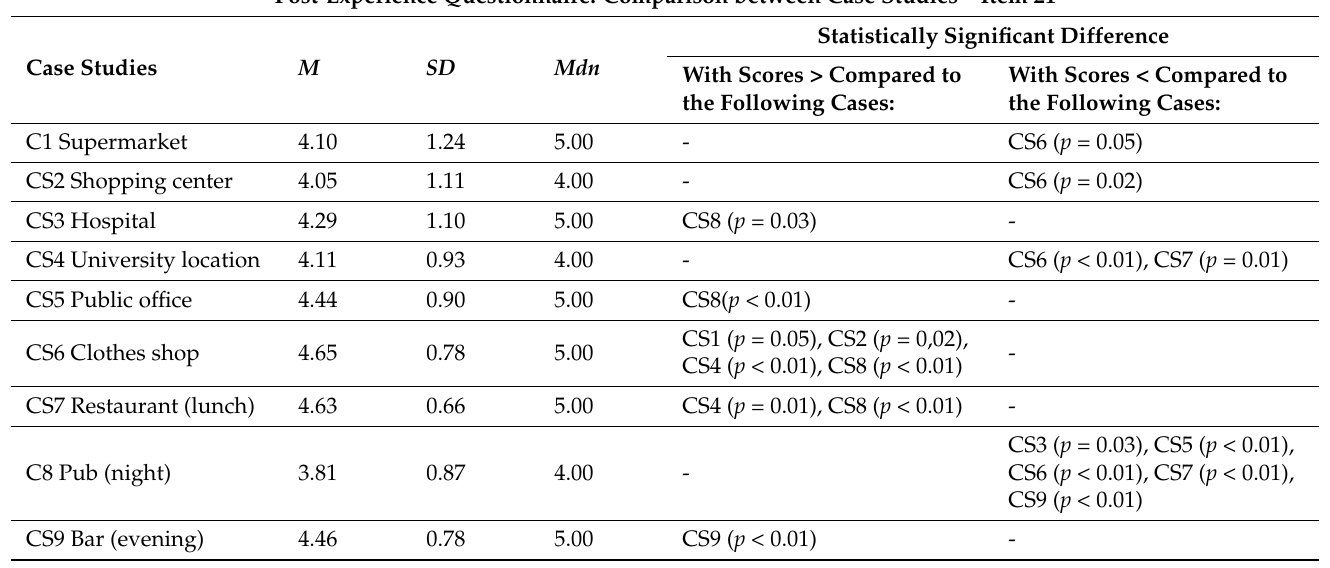
Table A23. Table shows the statistically significant differences ( p (BH)) that emerged from the comparison of item 21 in the different case studies (CS1–CS9). In the table is also reported the mean ( M ), the standard deviation ( SD ) and the median ( Mdn ). Own